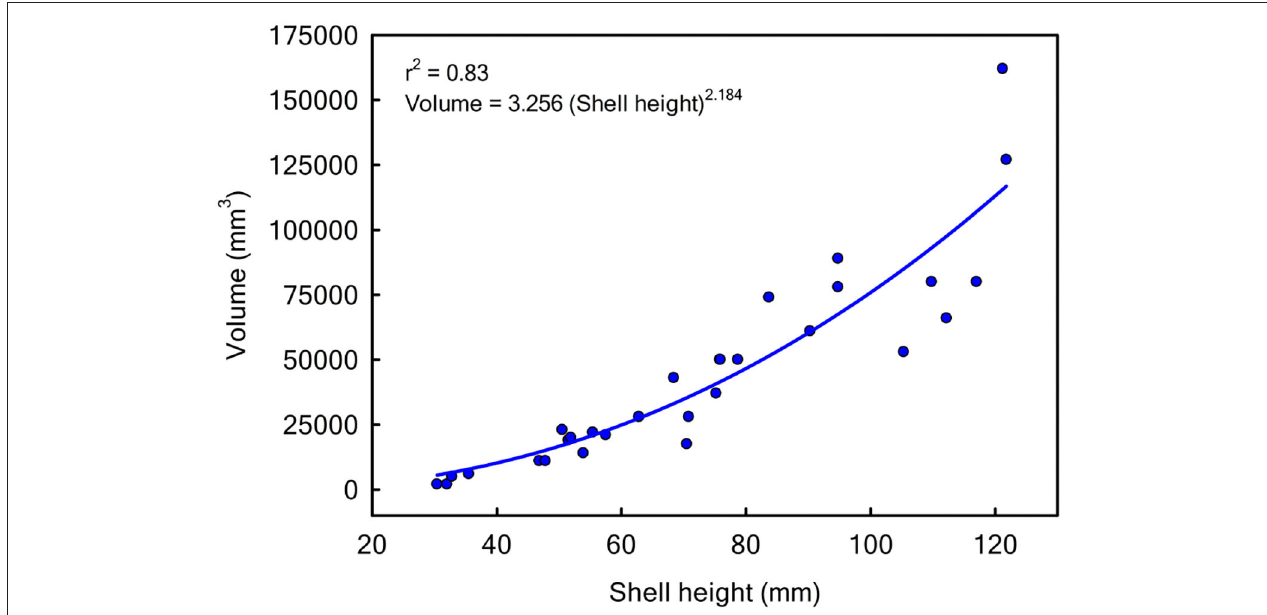
FIGURE 4 | Oyster length to volume conversion function: volume in mm 3 vs. shell height in